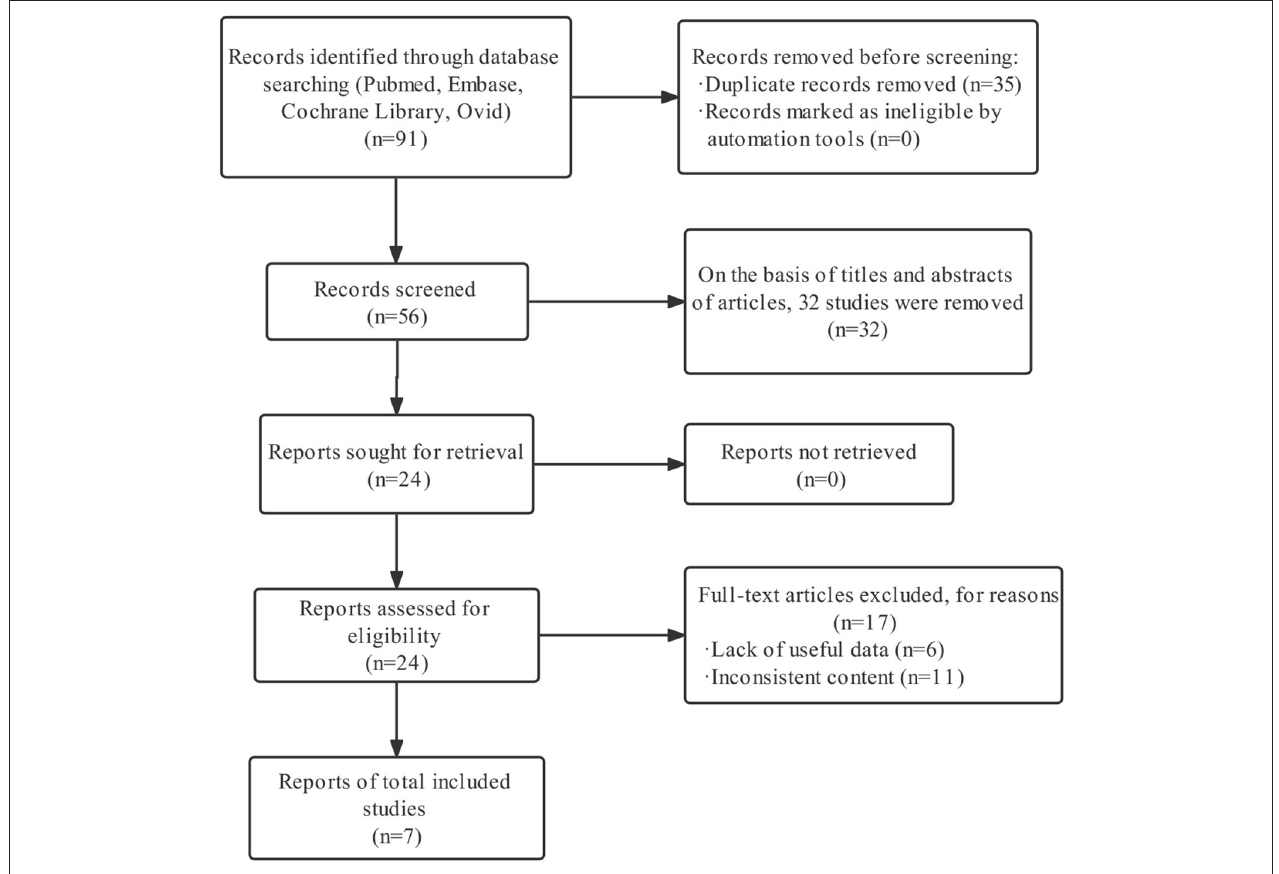
FIGURE 1 | Flow chart presenting the screening